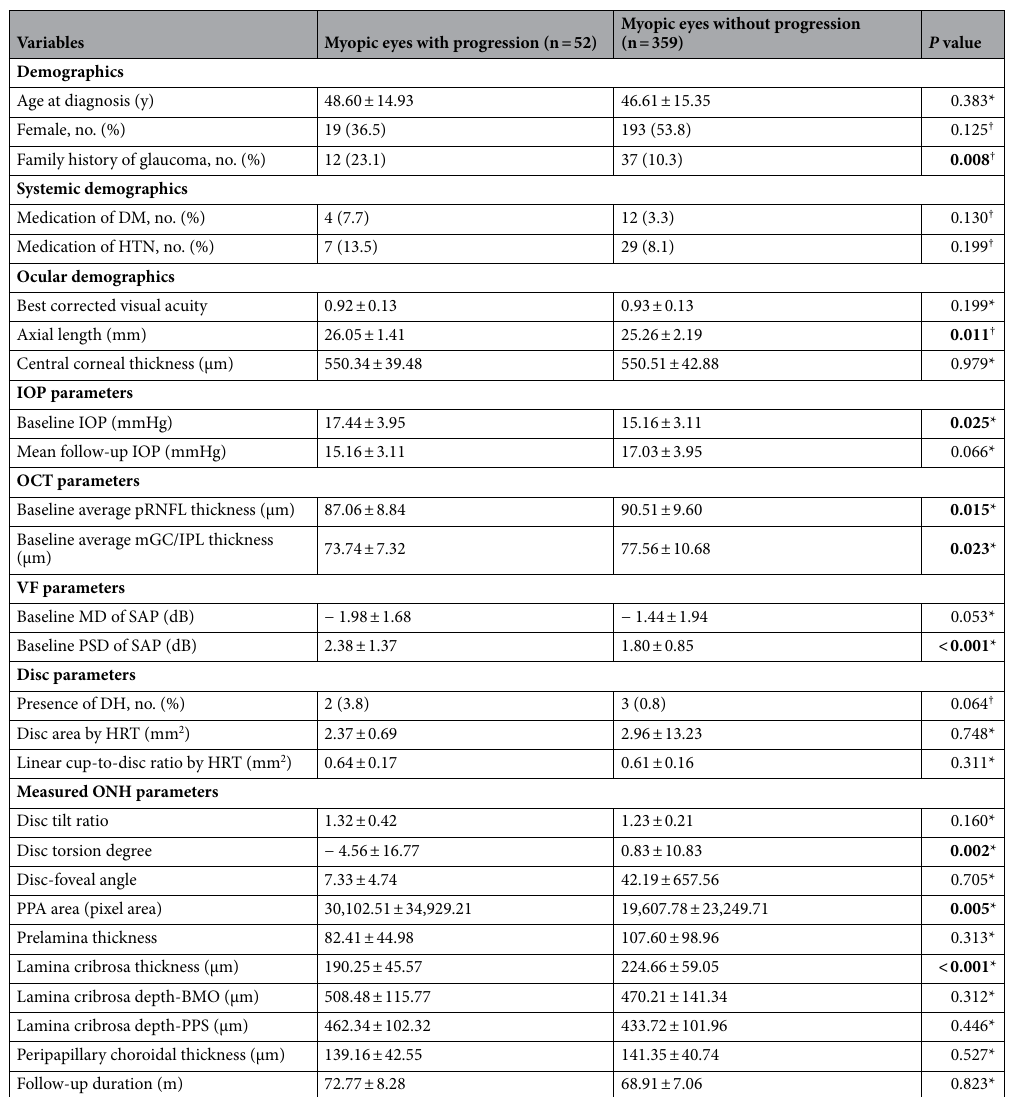
Table 5. Comparison between 411 NTG suspects with myopia that did and did not progress to NTG. DM, diabetes mellitus; HTN, systemic hypertension; OCT, optical coherence tomography; pRNFL, peripapillary retinal nerve fiber layer; mGC-IPL, macular ganglion cell-inner plexiform layer; IOP, intraocular pressure; VF, visual field; MD, mean deviation; PSD, pattern standard deviation; dB, decibel; MD, mean deviation; SAP, standard automated perimetry; DH, disc hemorrhage; HRT, Heidelberg retinal tomograph; ONH, optic nerve head; PPA, peripapillary atrophy; BMO, Bruch’s membrane opening; PPS, peripapillary sclera. Data are mean ± standard deviation unless otherwise indicated. *Student’s t test. † Chi-square test. Data are mean ± standard deviation unless otherwise indicated. Factors with statistical significance are shown in